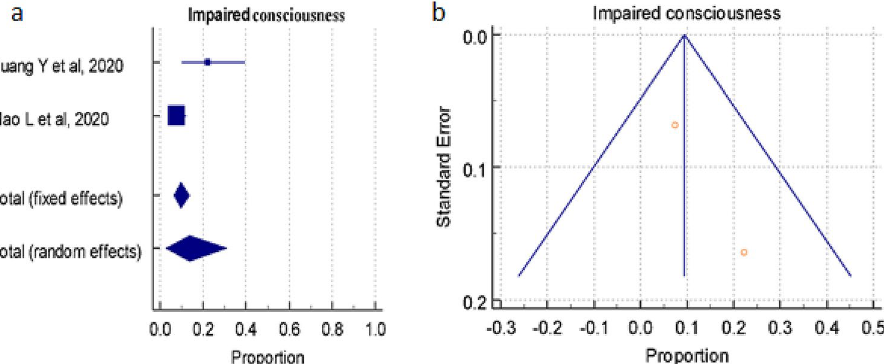
Figure 10. ( a ) Forest plot showed pooled prevalence/incidence of Impaired Consciousness among patients with COVID-19. ( b ) Funnel plot showed publication bias among studies evaluating neurological complications of COVID-19.